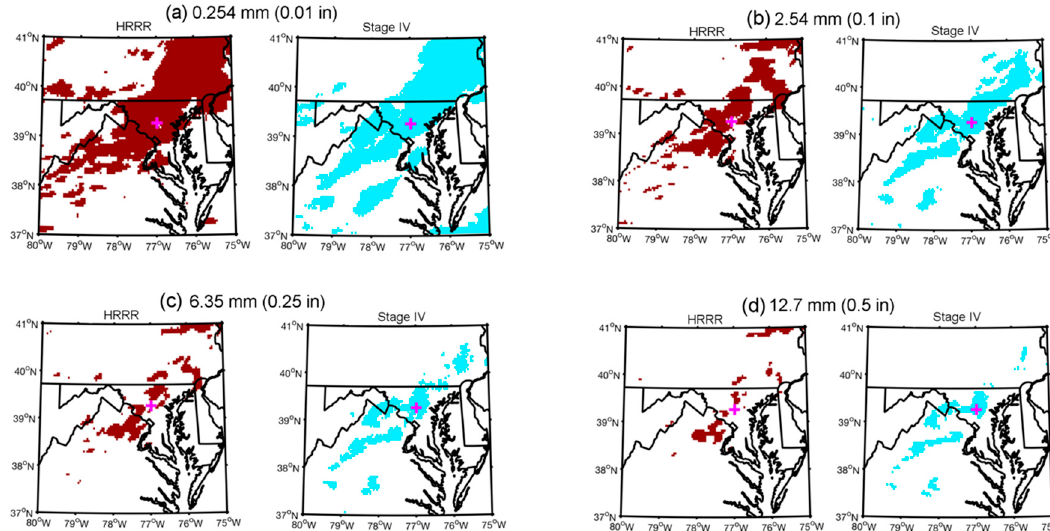
Figure 4. Example of delineation of objects at variable thresholds: ( a ) 0.254 mm, ( b ) 2.54 mm, ( c ) 6.35 mm, and ( d ) 12.7 mm. In each panel, the left image corresponds to the HRRR one-hour precipitation forecast, and the right image corresponds to the Stage IV analyzed hourly precipitation.